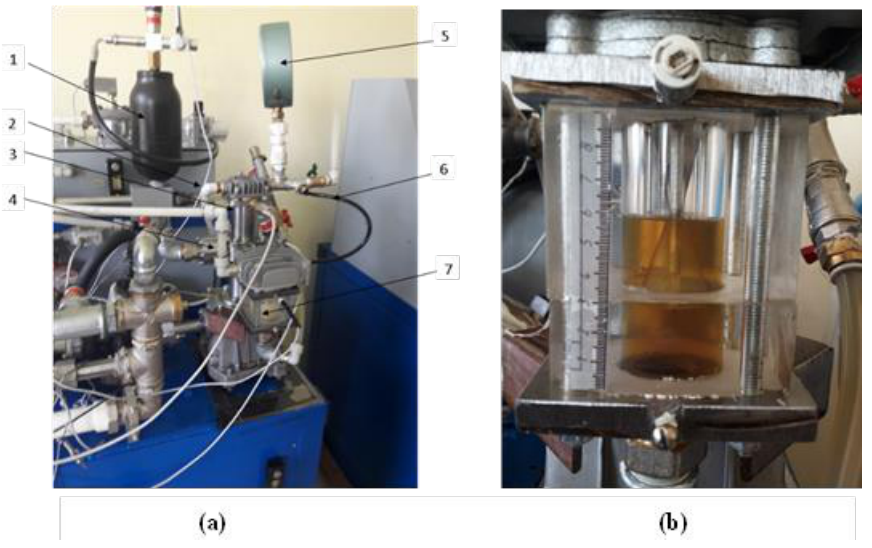
Figure 7. A general view of the prototype installed on the stand: ( a ) General view of two-stage PHPM with a gas cap (1 — Gas cap; 2 — Suction line; 3 — Stage 1 of a two-stage PHPM; 4 — Discharge line; 5 — Manometer; 6 — Inter -stage pipeline; 7 — Stage 2 of two-staged PHPM); ( b ) Image of the